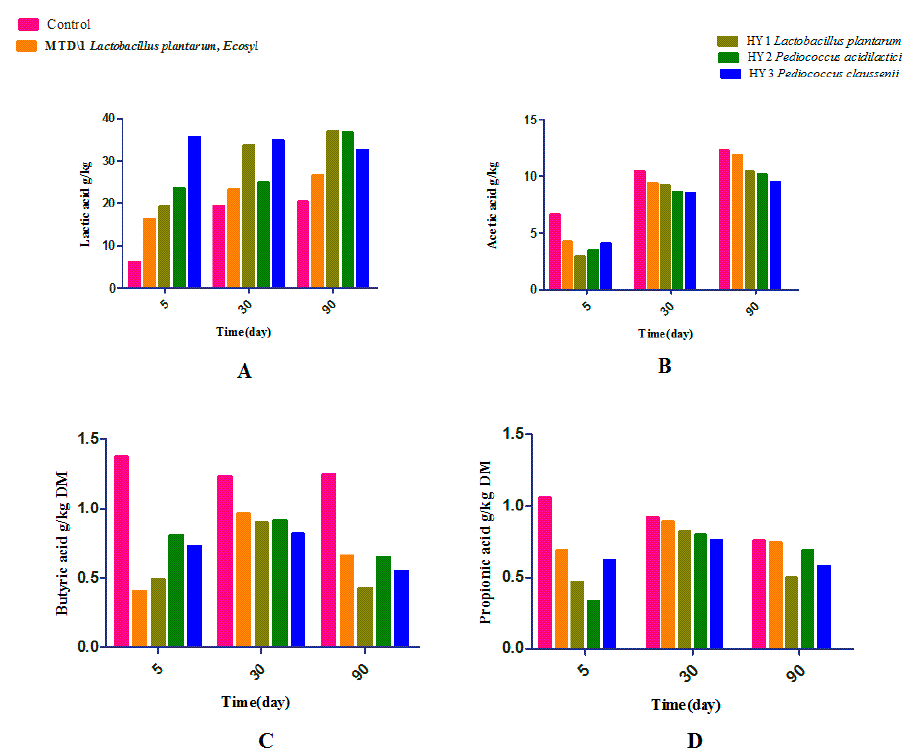
Figure 5. Effect of LAB inoculants on organic on Napier grass silage ( A ) lactic acid, ( B ) acetic acid, ( C ) butyric acid, ( D ) propionic acid during different opening times. Table 3. Effects of LAB inoculant on DM, Ammonia-N and microbial counting of sweet sorghum ensiling for 90